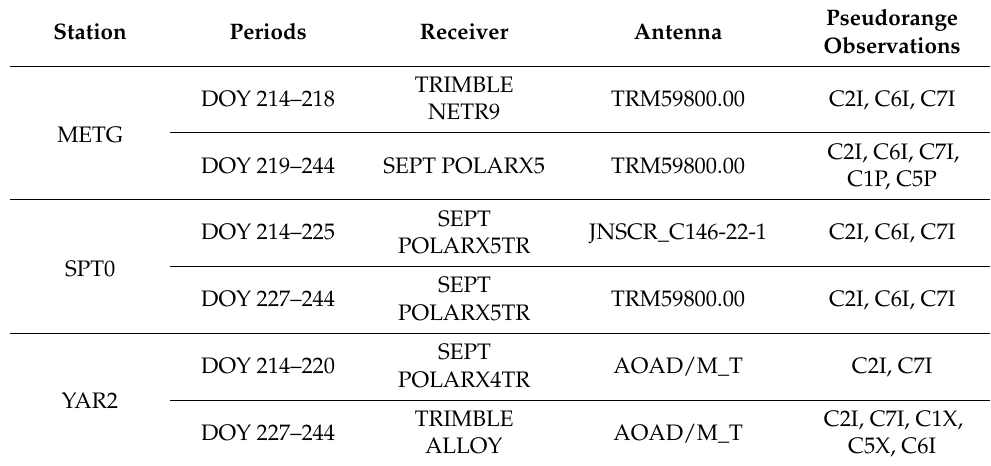
Table 5. BDS signals and their corresponding frequencies and code